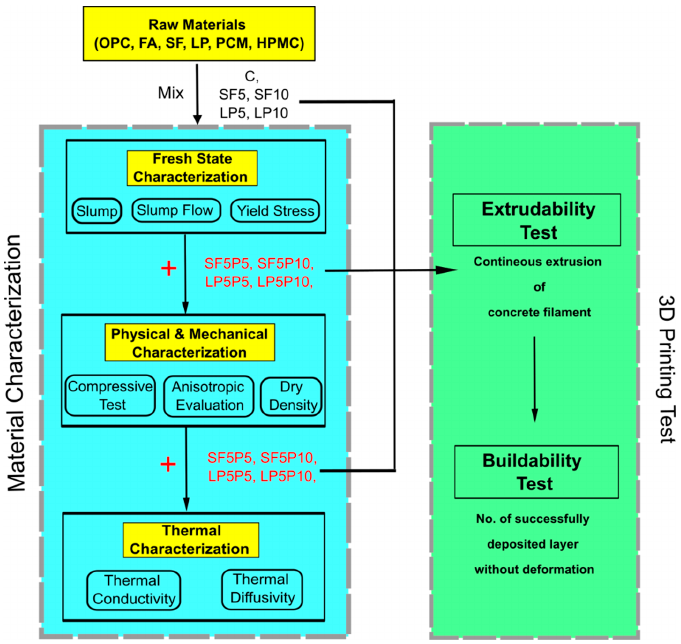
Figure 5. Flowchart of the test methods.